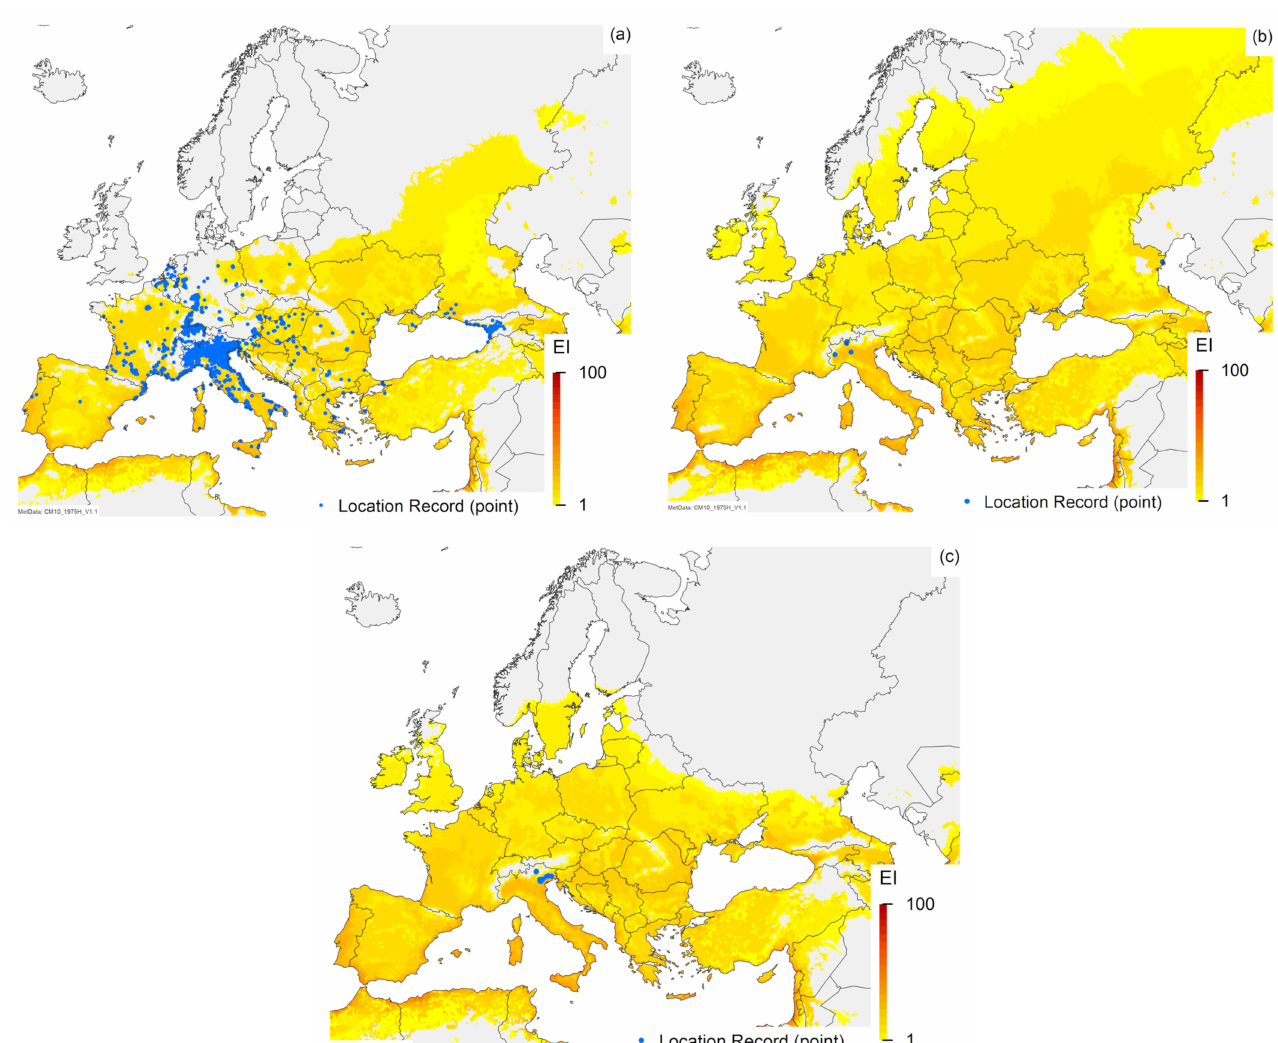
Figure 4. Modelled climate suitability (CLIMEX Ecoclimatic Index) for ( a ) Halyomorpha halys , ( b ) Trissolcus japonicus and ( c ) Trissolcus mitsukurii in Europe modelled using CLIMEX Compare Locations. Suitability for all three species is mapped as a composite of natural rainfall and irrigation based on identified irrigation areas